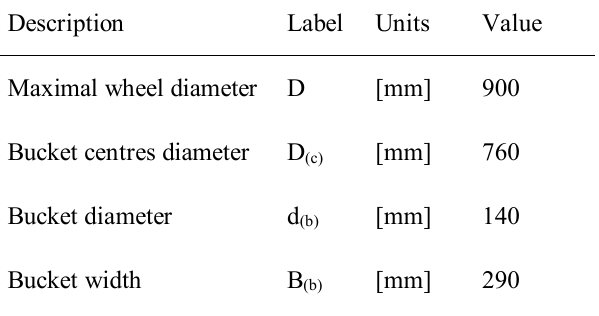
Table 1. Basic wheel dimensions.